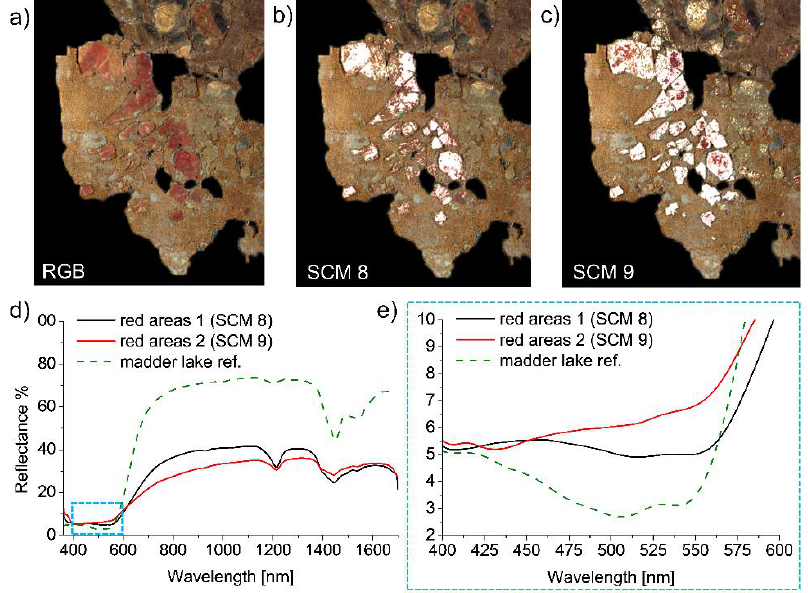
Figure 4. Spectral analysis of the orange decorations and the bluish background: ( a ) RGB image highlighting the relevant region revealed by SCM 8 ( b ) and 9 ( c ). ( d ) FORS spectra of the red pigments in comparison with the reference spectrum of madder lake. The dashed light-blue rectangle evidences the range of 400–600 nm, which is magnified ( e ) to make visible the characteristic features of the pigments.